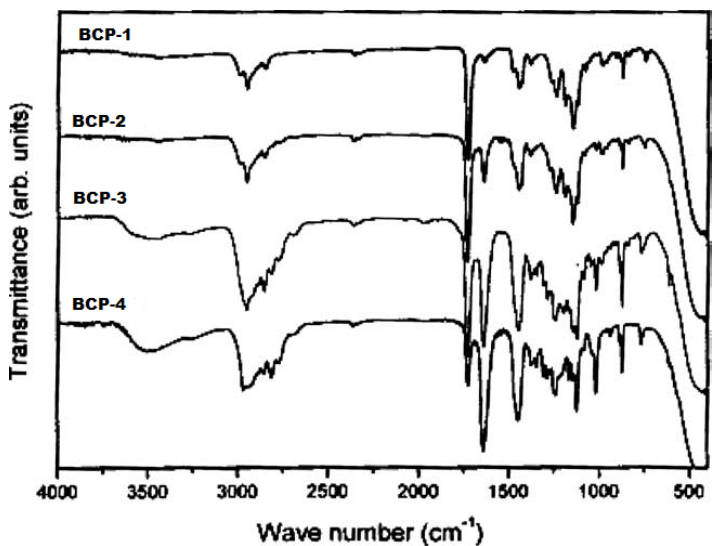
Figure 2. FTIR spectra of copolymers obtained as thin films on NaCl